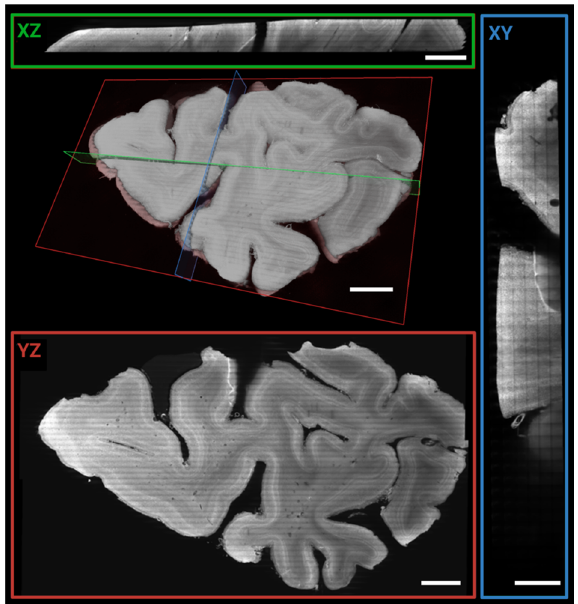
Fig. 2 Mosaic 16 overview scan of entire occipital lobe sample. 3D rendering and orthogonal planes of 16.4 µ m isotropic data. Orthogonal views of 50 µ m MIP ( XY : green, XZ : red, YZ : blue) of the entire 3 mm thick sample. Scale bars: 5 mm for XZ , YZ , and volume rendering respectively and 2.5 mm for XY